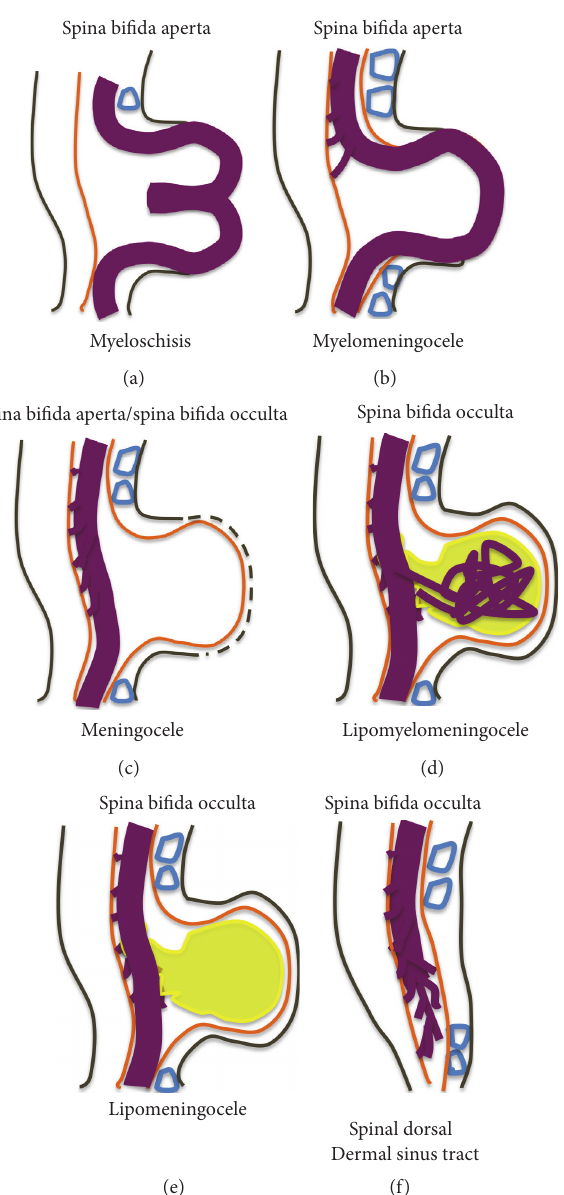
Figure 1: Schematic representation of the open (aperta) and close (occulta) types of spina bifida. (a) Myeloschisis which represents the most severe form of open spina bifida. (b) Myelomeningocele which represents another typical severe form of open spina bifida (spina bifida aperta/spina bifida cystica). The typical representation is that of the spinal cord lying outside the spinal canal. (c) Meningocele that represents open or close spina bifida (the skin may or may not be present) but spinal cord does not lie outside the spinal canal. (d) Lipomyelomeningocele that represents closed spina bifida (spina bifida occulta) (covered with skin) but spinal cord is intermeshed with lipid globules (in yellow). (e) Lipomeningocele that exhibits closed spina bifida but spinal cord does not lie outside spinal canal even though lipid globules are present. (f) Spinal dorsal dermal sinus tract; spina bifida occulta with vertebral arches missing (often asymptomatic and is thought to be a mesodermal defect and a defect of secondary